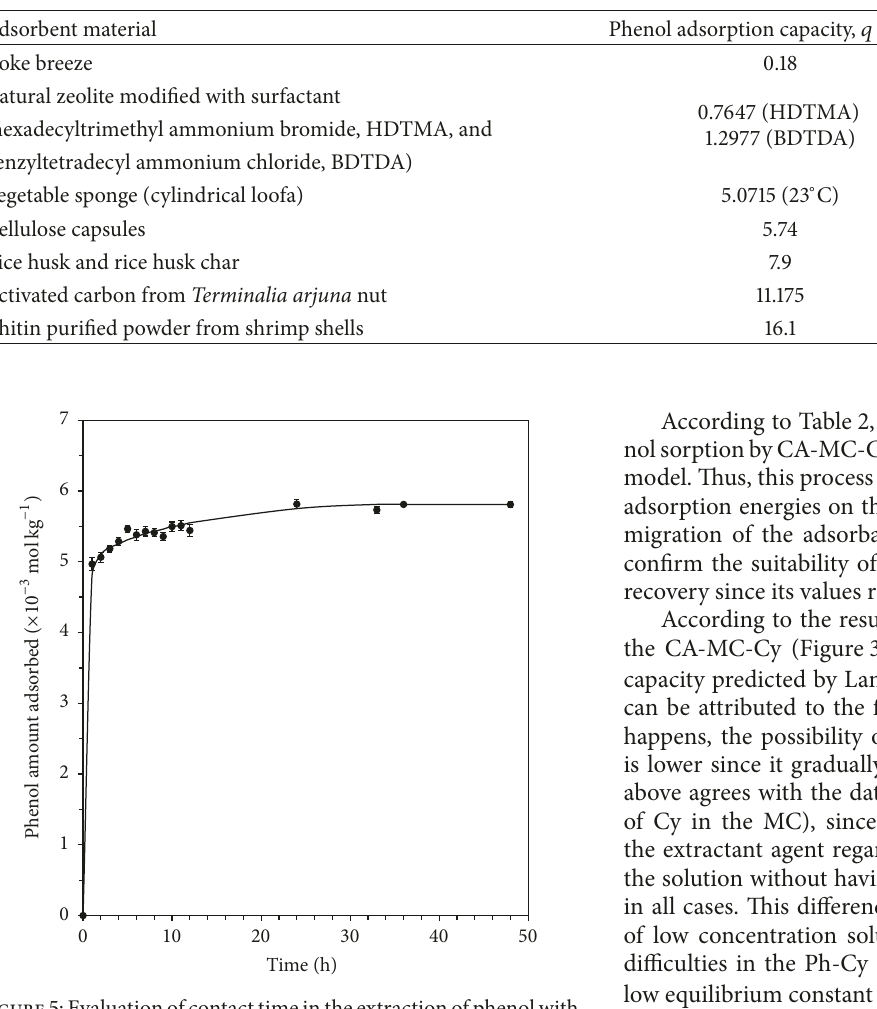
Table 3: Comparison of the phenol adsorption capacity ( 𝑞 ) of several adsorbents derived from natural material.